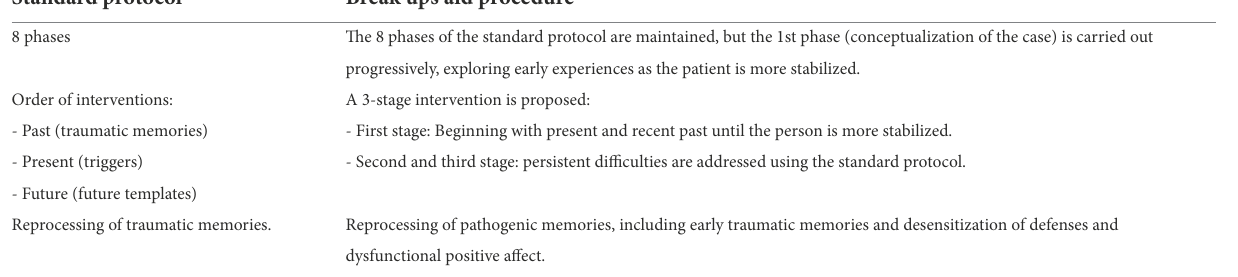
TABLE 2 Comparing EMDR’S standard protocol and BUAP. Standard